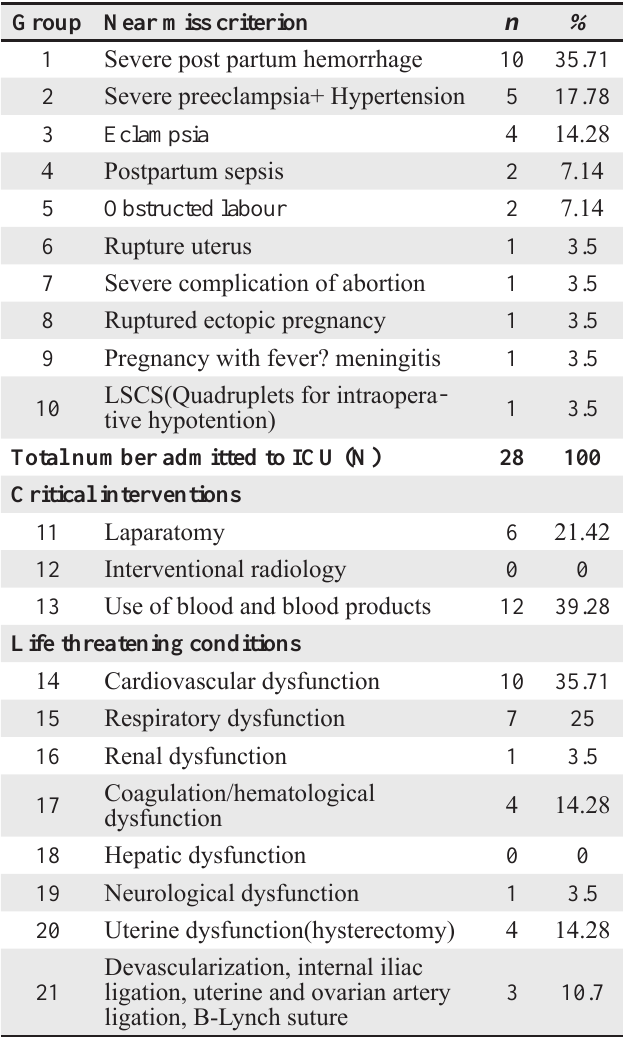
Table 3 : Causes of hemorrhage and requirement of blood and blood products